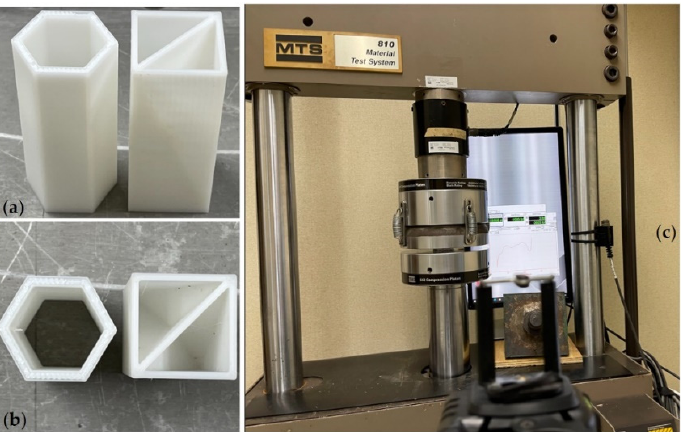
Figure 4. ( a ) 3D-printed test specimens. ( b ) 3D-printed specimens infill printing pattern. ( c ) Quasi- static compression testing system.